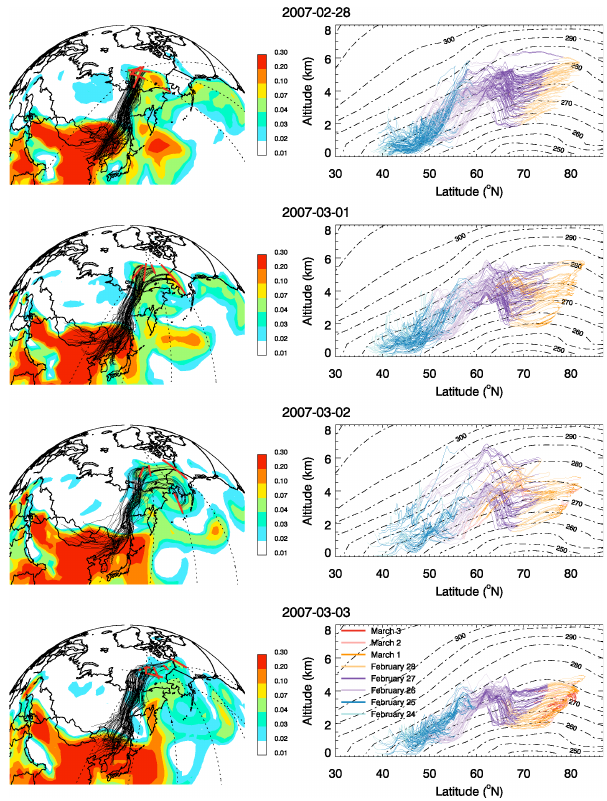
Figure 1. February 28-March 3, 2007 Arctic haze event. Left column: daily Asian AOD (550 nm) calculated with GEOS-Chem. CALIPSO orbits are indicated by dashed lines and the parts of the orbit where the haze layers are observed are shown in red. Backtrajectories corresponding to the observed aerosol layers are shown in black, starting with 4-day backtrajectories on February 28, and incremented by 24 hours for each subsequent day. Right column: height (altitude above mean sea level) evolution as a function of latitude for backtrajectories shown on the left panel. The backtrajectories are color-coded based on the date (see legend on bottom panel). The potential temperature surfaces (dashed lines) are zonally averaged between 120ºE and 150ºW and temporally averaged between February 25, 0Z and the time the last plume was observed for each day.